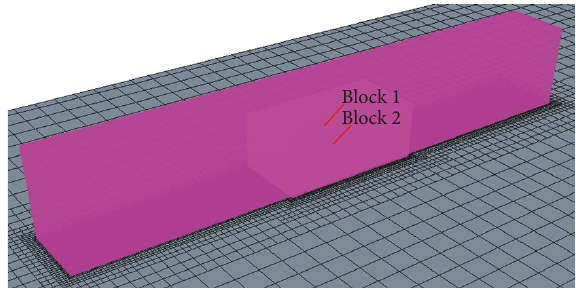
Figure 3: Refined meshes in the computational domain of pan-